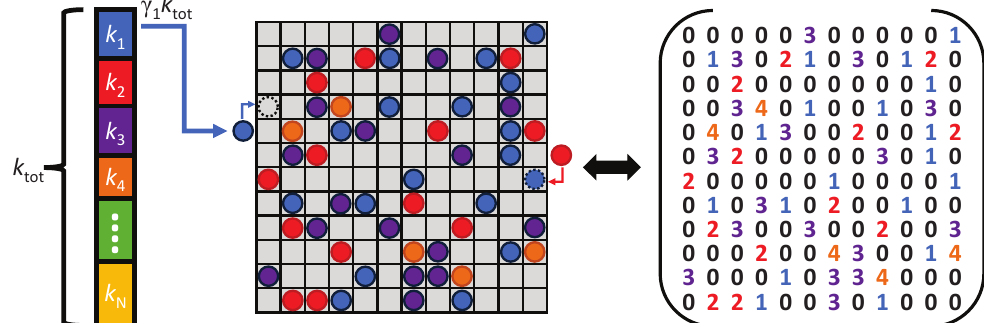
Figure 4. Kinetic Monte Carlo simulation on lattice diagram. For each reaction site, an identifiable number is allocated corresponding to a reaction if the selection condition of a certain reaction path is satisfied in Equation